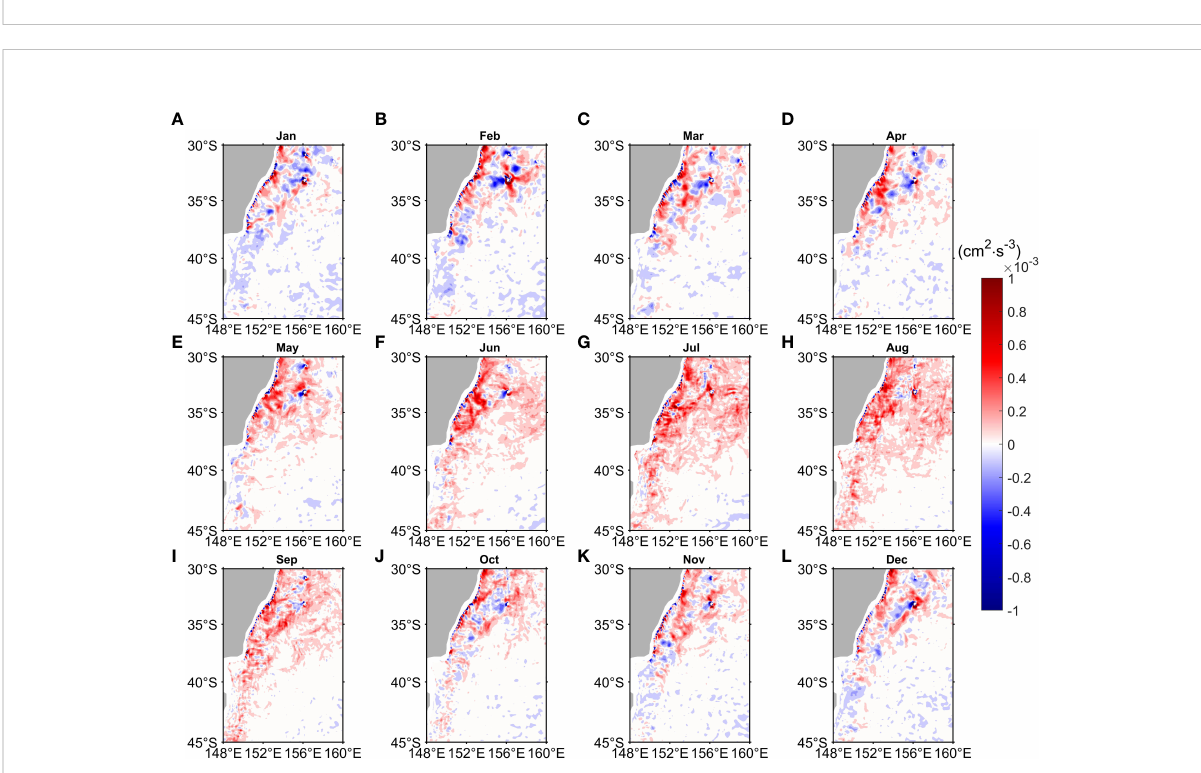
FIGURE 7 Monthly mean baroclinic conversion rate (BCR, Unit: cm 2 s -3 ) distribution averaged over the upper 300 m layer from OFES during July 1999- October 2009 for (A) January, (B) February, (C) March, (D) April, (E) May, (F) June, (G) July, (H) August, (I) September, (J) October, (K) November and (L) December. BCR is de fi ned in Eq.